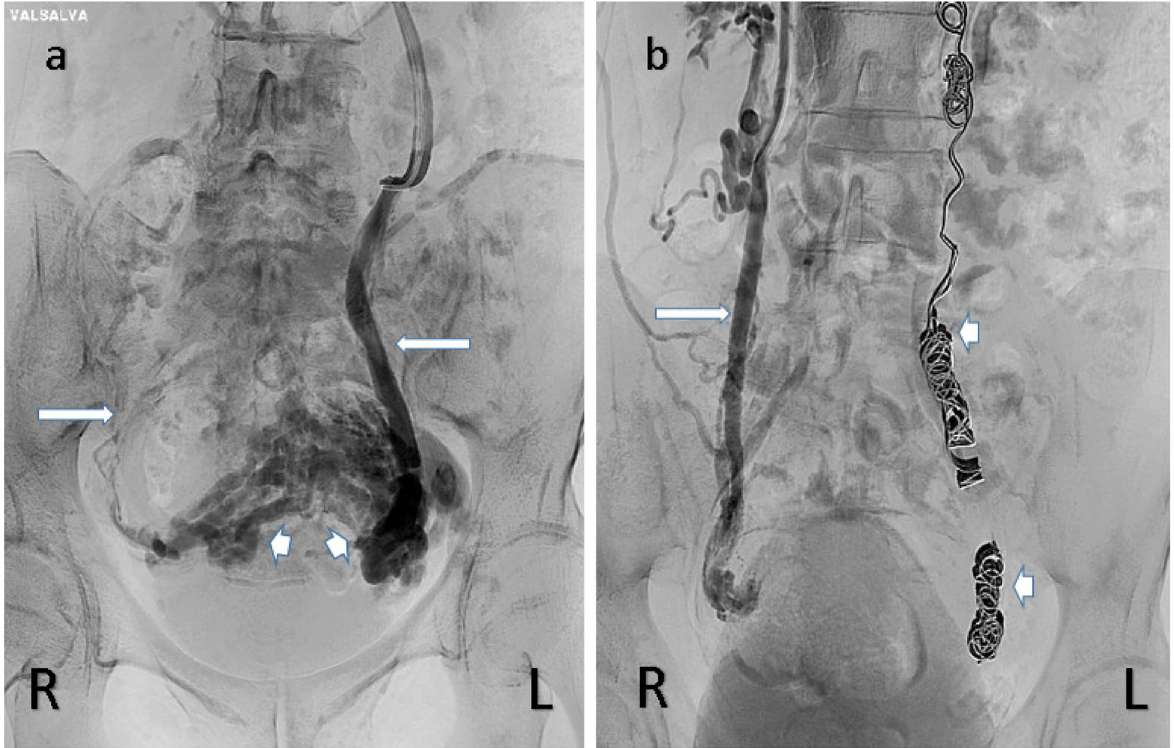
Fig. 6 6 a Left Ovarian venography with Valsalva The left ovarian venogram (long arrow on left) in a multiparous woman, shows significant venous dilatation with extensive varicosities (arrow heads) and reflux across the midline to the right ovarian vein (long arrow on right). 6 b Right ovarian venography following left ovarian vein coil embolization (arrow heads). The ROV (long arrow) was embolized with